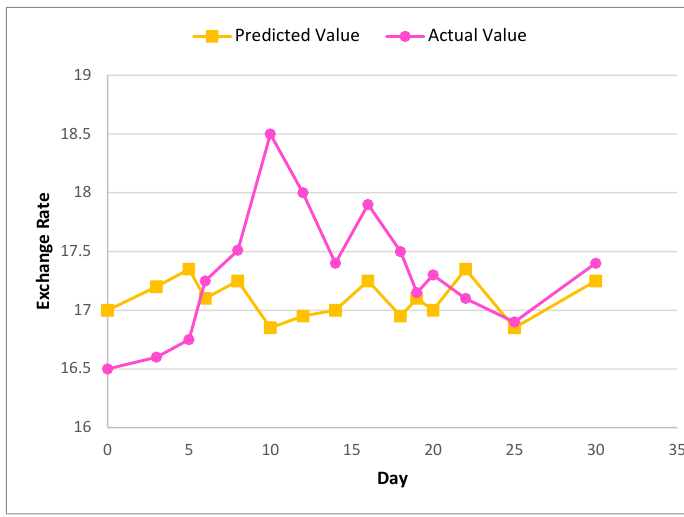
Figure 6. Actual and predicted value of Ether using XGBoost for 30 days.